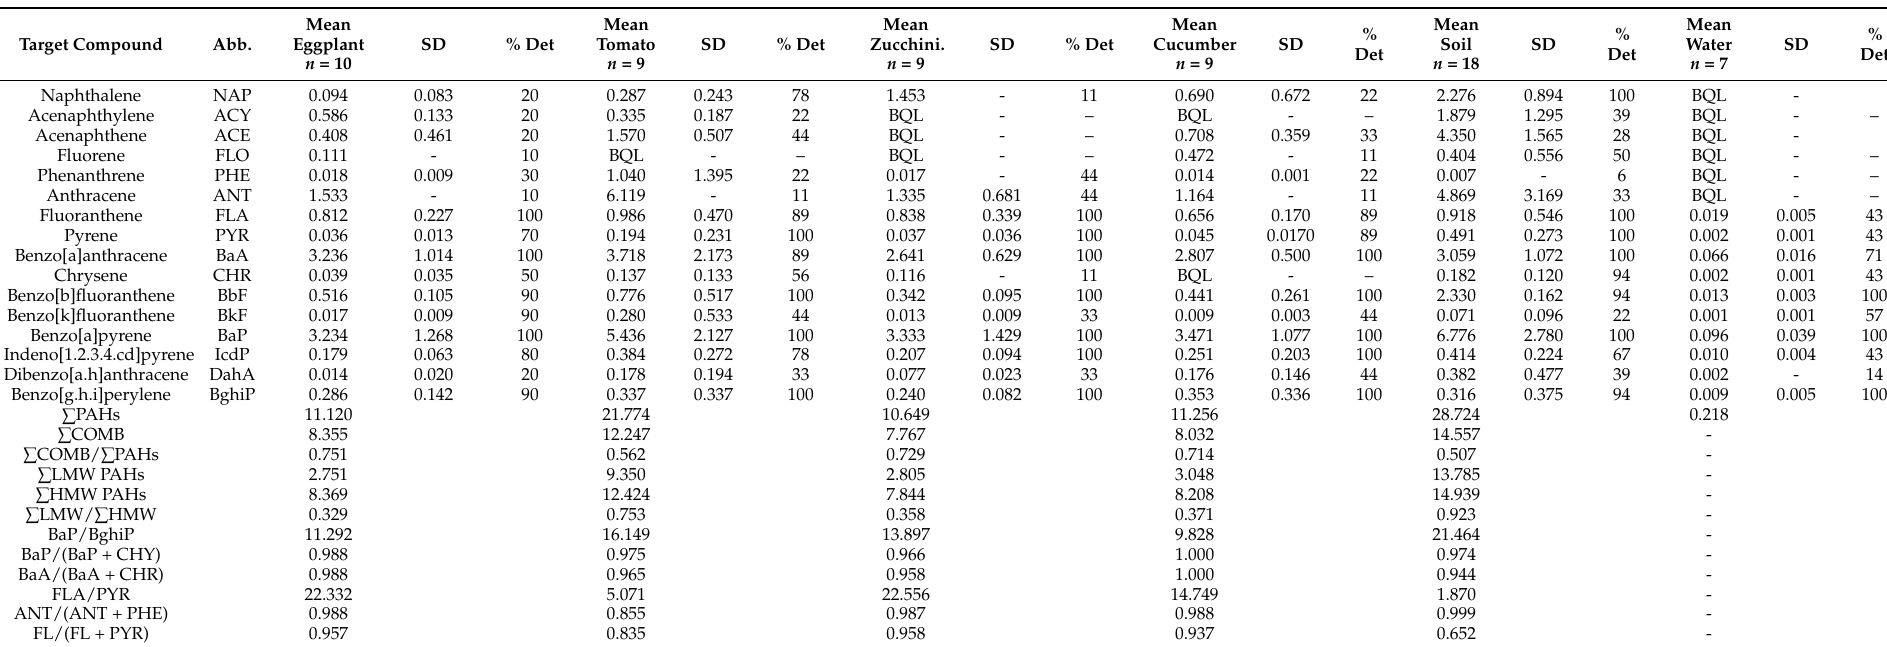
Table 1. Mean ( µ g kg − 1 for plants and soil and µ g kg − 1 for water), standard deviation, and isomer ratio of the PAHs in the studied